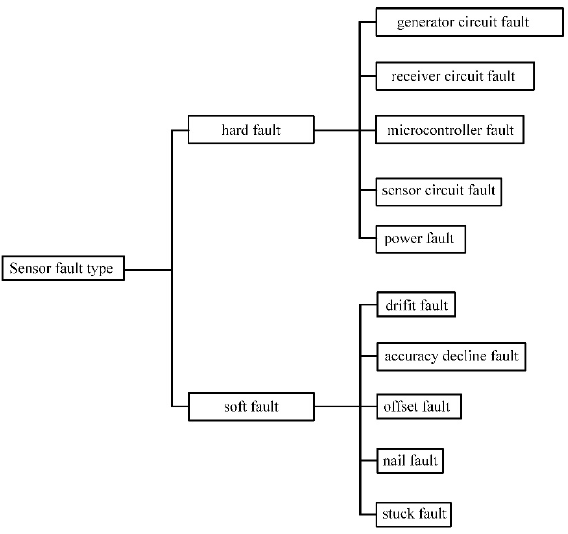
Figure 3. Types of sensor faults in agricultural sensor